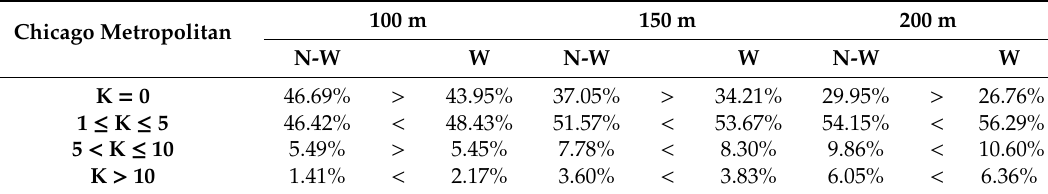
Table 1. K-nearest neighbors (KNN) for Chicago metropolitan.